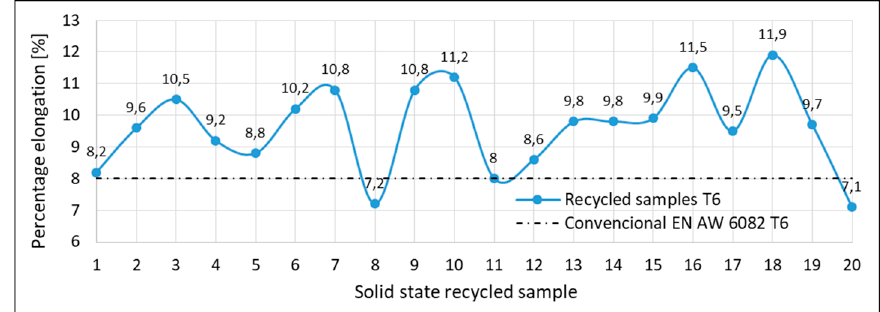
Figure 7. Percentage elongation results for all 20 SSR samples and minimum required percentage elongation proposed by EN 755-2:2016 standard.